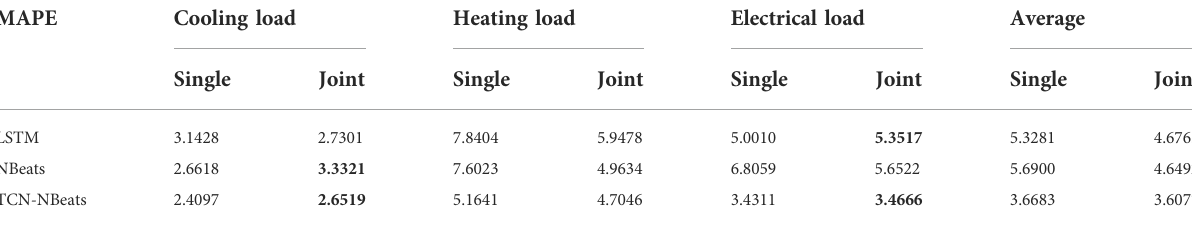
TABLE 1 Comparison of MAPE between single and joint forecasting under different models. MAPE